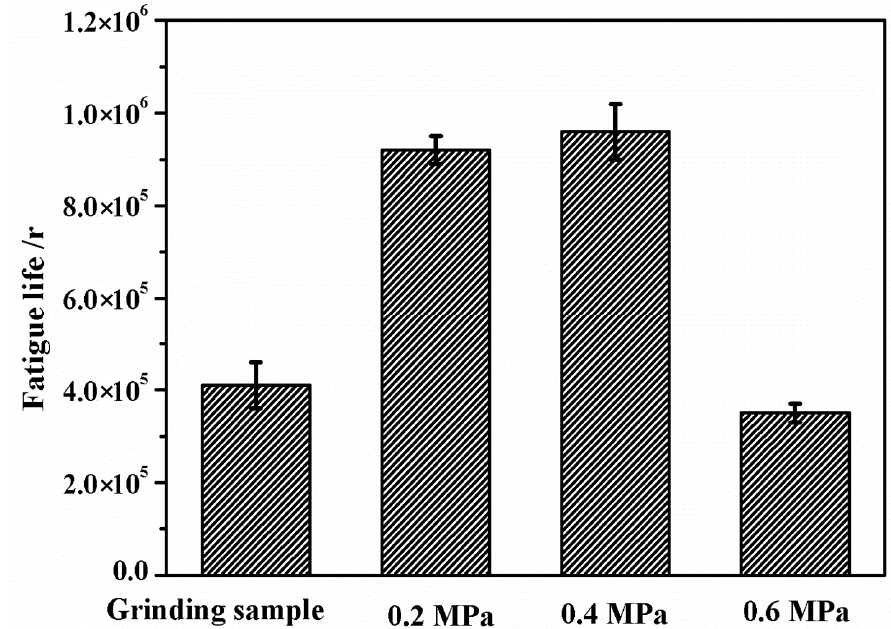
Figure 4. Variation of rolling contact fatigue (RCF) life of the grinding processing sample and the samples after surface ultrasonic rolling (SURT) with different static pressures.